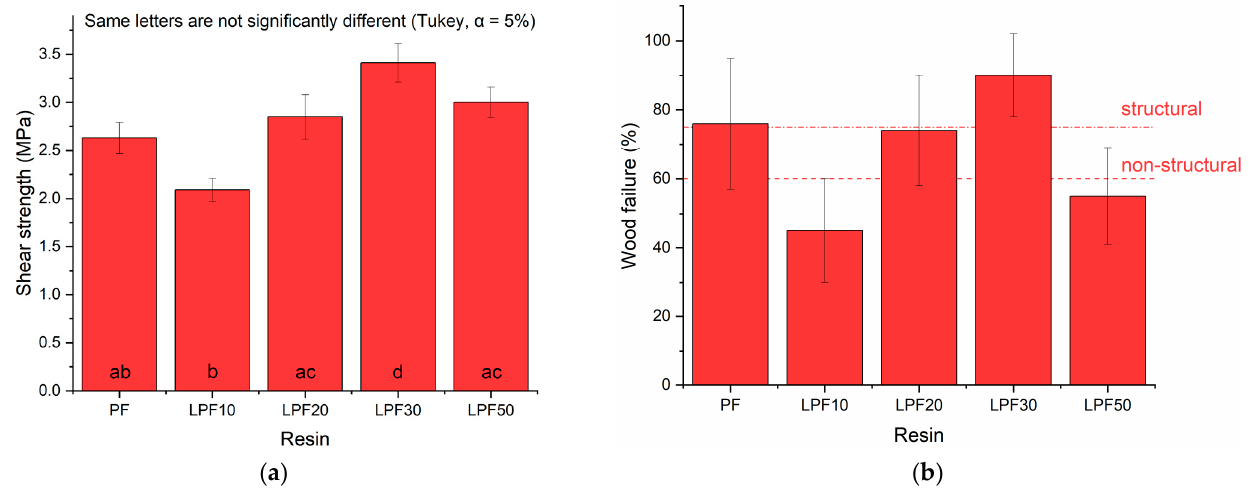
Figure 2. Influence of different resins on: ( a ) tensile shear strength, and ( b ) wood failure.